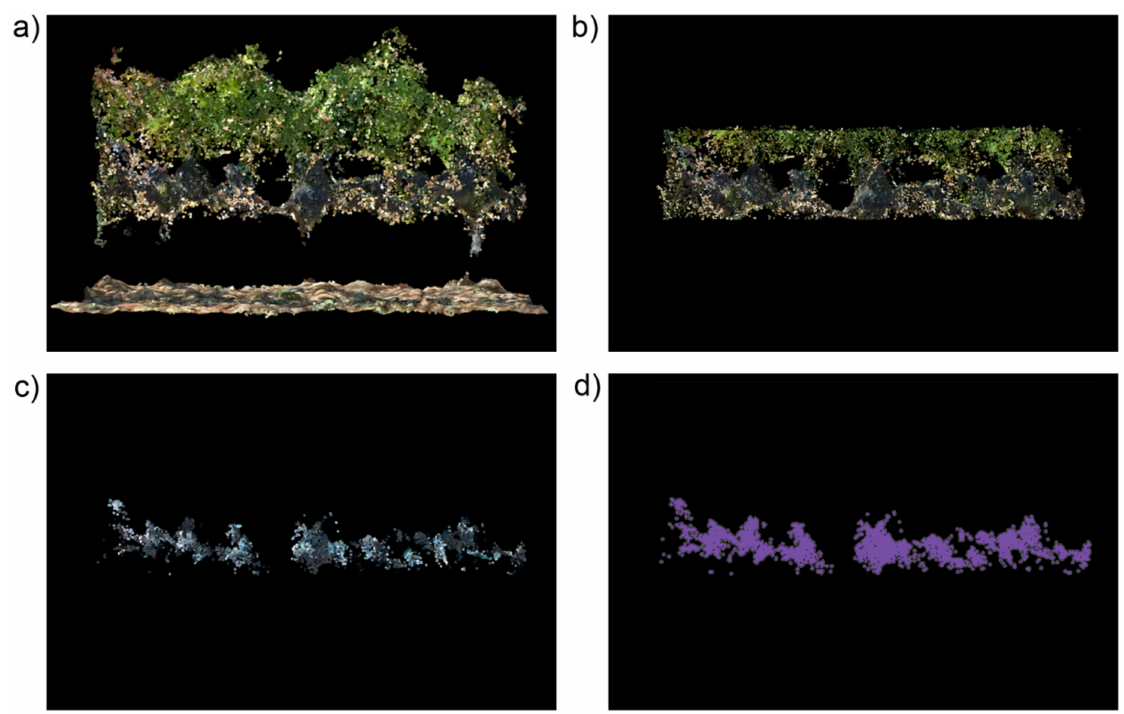
Figure 4. Graphical description of the main steps of the grape detection workflow (a segment of a vinerow with two sides leaf removal is used for visualization purposes): ( a ) original point cloud; ( b ) point cloud after the removal of the points with a height below 0.5 m and over 1 m; ( c ) points classified as grapes after the color filtering and the noise removal; ( d ) buffer area of the points classified as